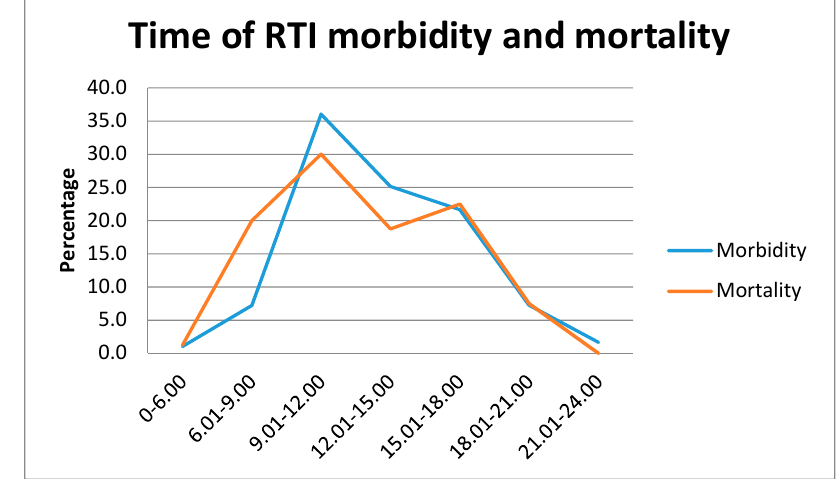
Figure 5. Time of RTI morbidity and mortality.